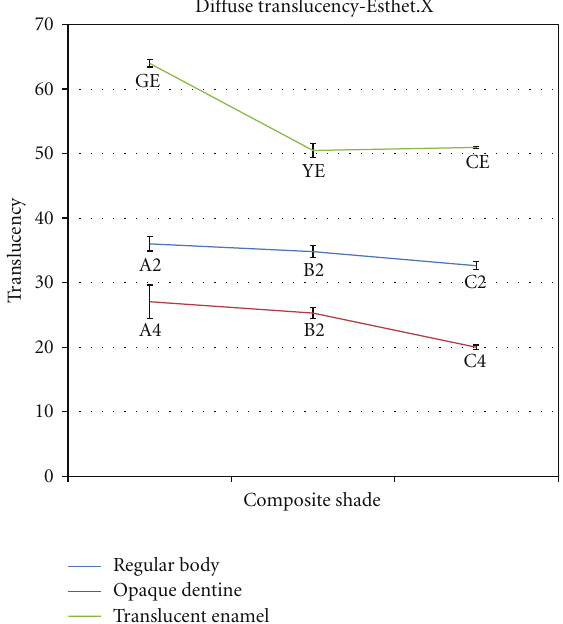
Figure 2: Mean total translucency of di ff erent shades of Esthet-X composite resin.